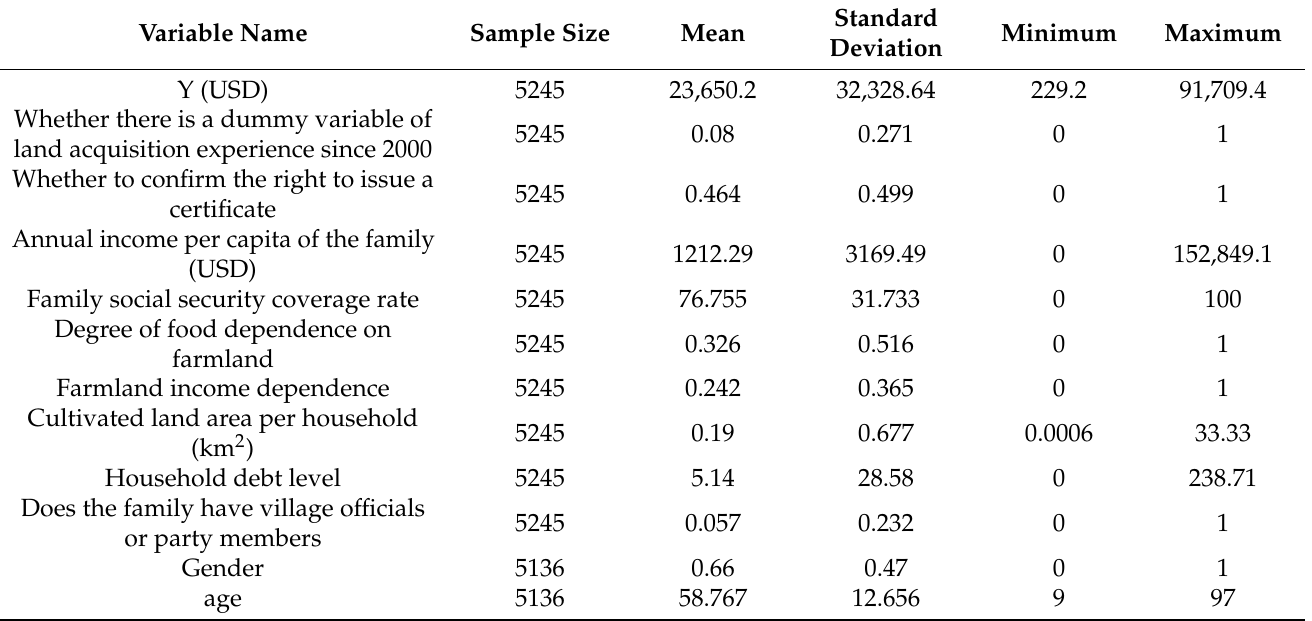
Table 3. Descriptive statistics of main